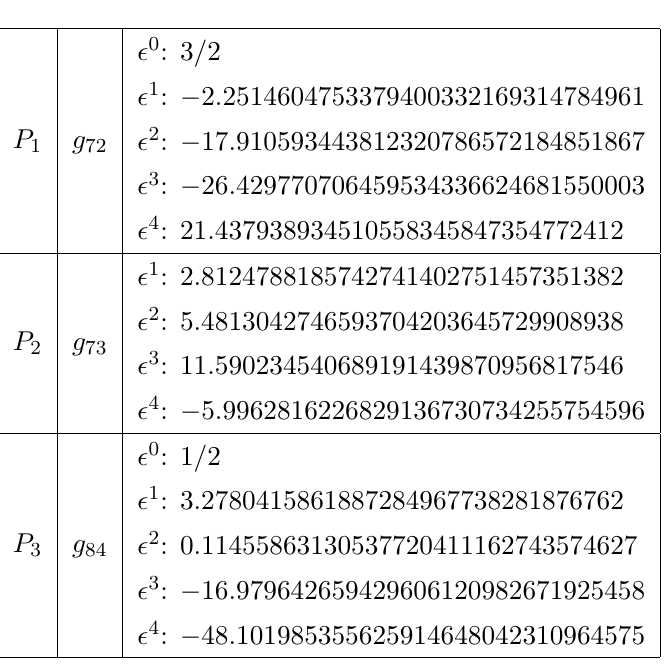
Table 2 . Numerical results for the non-zero top sector element of each family with 32 significant